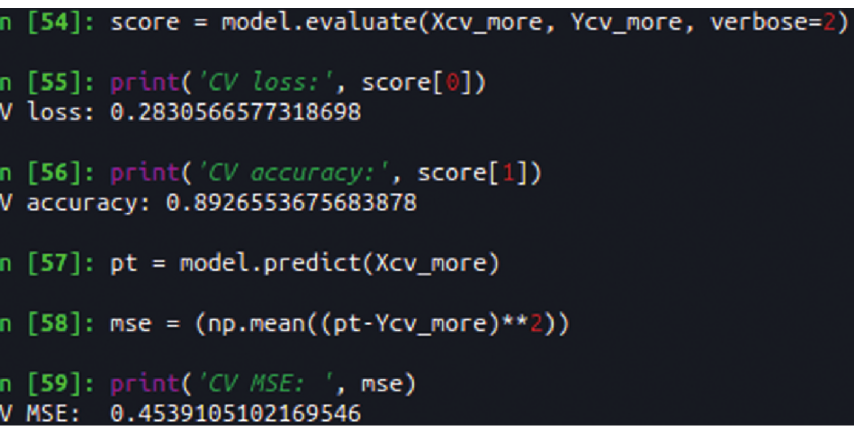
Figure 5: CNN Training